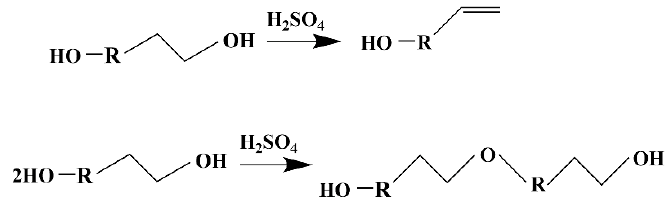
Figure 4. Condensation reaction between liquid solvents of polyols.